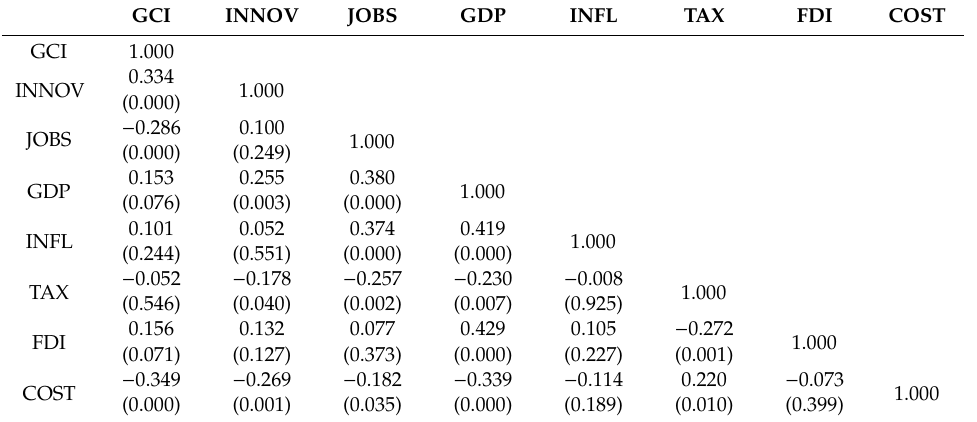
Table 4. The correlation matrix of the variables.